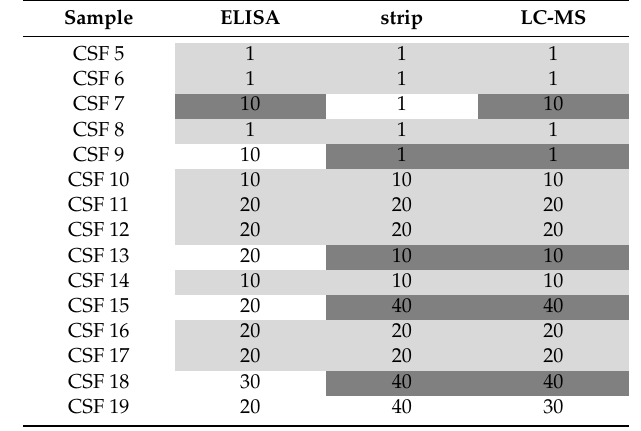
Figure 4. Application of the blood level categorization system to the results of the di ff erent methods. Shown are the classification results for ELISA ( A ), Combur10-Test ® Strips ( B ), and MS ( C ) depending on the defined contamination levels listed in Table 2. The results showed a high classification overlap for the di ff erent methods for samples with blood spike-in concentrations 1% to 0.01%. Table 3. Application of all three methods on independent dataset. Fifteen di ff erent CSF samples were analyzed with hemoglobin ELISA, Combur10-Test Strip, and LC-MS. The respective results were classified to the defined contamination levels as listed in Table 2. Samples that were assigned by all three approaches to the same blood level are highlighted in light gray, and samples that were assigned to the same level by two approaches are marked in dark